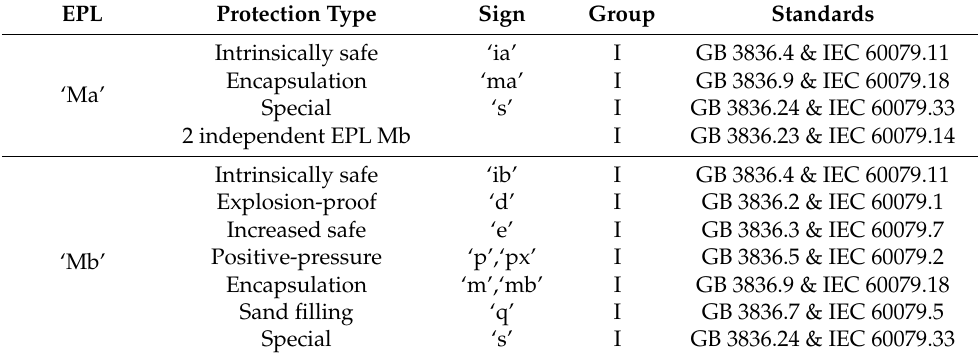
Table 7. Relationship between protection type and equipment protection